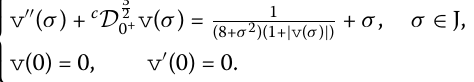
Hence, from Theorems 13 and 14, the given system (22) is HUS and HURS . The HUS and HURS of (22) do not depend on the initial value condition. The solution u ( σ ) of (22) with the given boundary conditions and initial value conditions u (0) = 0 and u (cid:4) (0) = 0 is shown in Figs. 1 and 2,